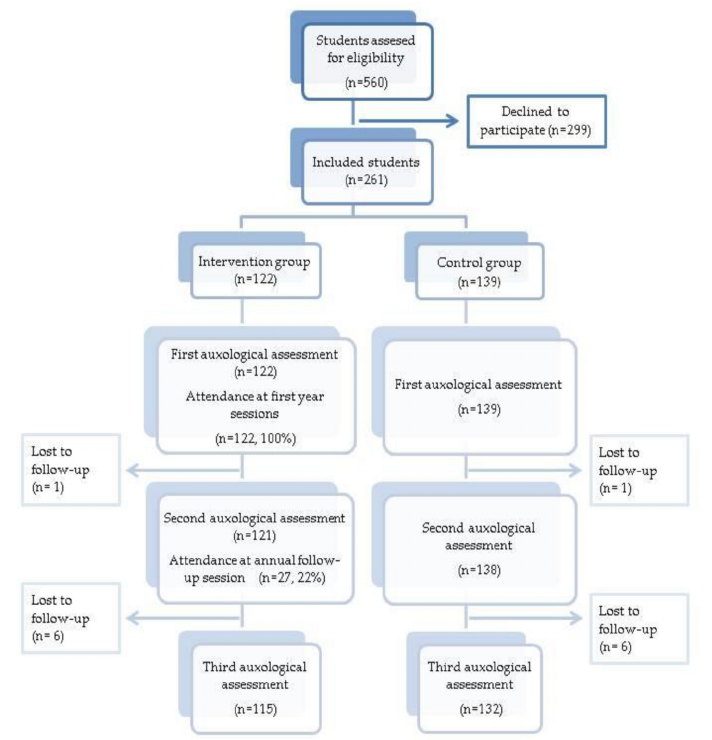
Figure 1. Study flow